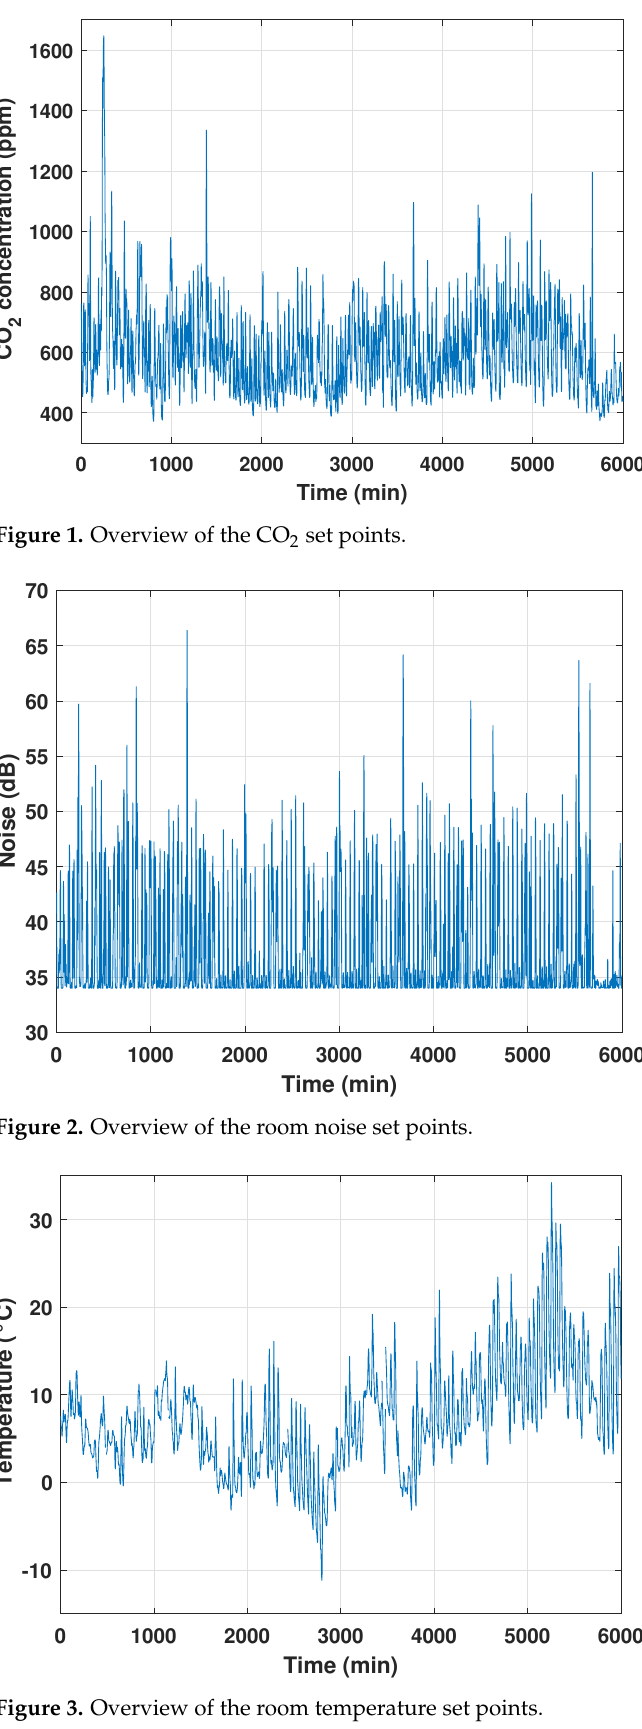
Figure 3. Overview of the room temperature set